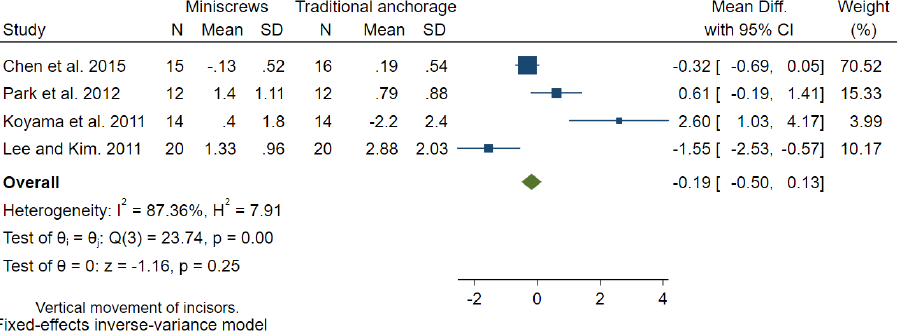
Figure 4. The Forest plot showed the vertical movement of incisors between miniscrews vs. traditional